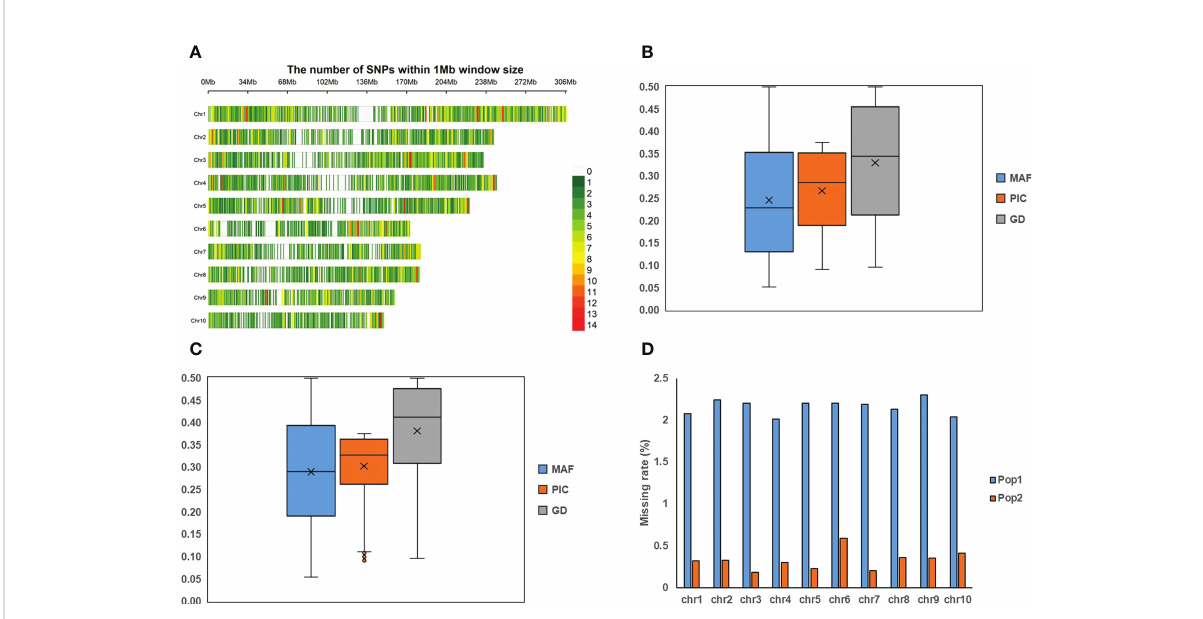
FIGURE 1 The information of 5.5K loci panel and the genotyping pro fi les in two populations. (A) The distributions of 5.5K target markers on ten chromosomes. (B, C) represent the distributions of minor allele frequency (MAF), polymorphic information content (PIC), and gene diversity (GD) in Pop1 and Pop2, respectively. (D) The missing rate on ten chromosomes in both